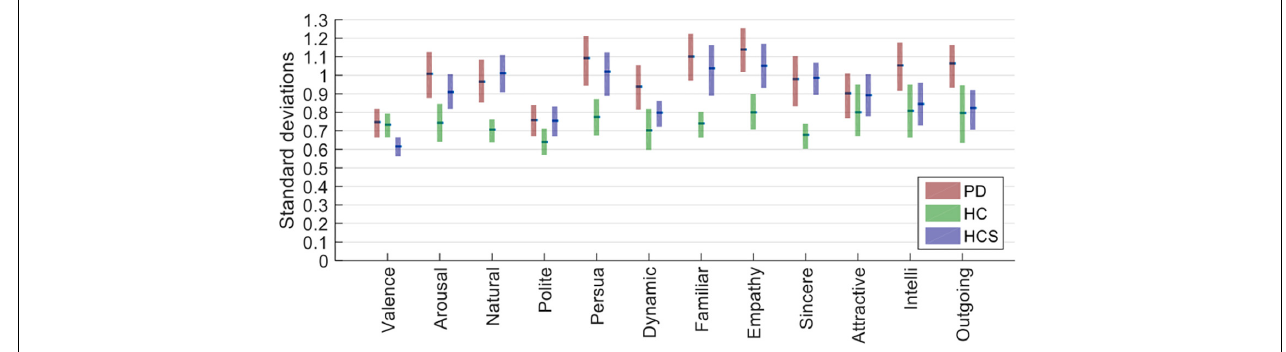
FIGURE 1 | Standard deviations for the three groups (averaged across actors first and then determined for participants and averaged across all 27 expressions). Bars show the estimated median of the bootstrapped sample distribution, and the boxes show the 95% confidence intervals estimated from bootstrapping.